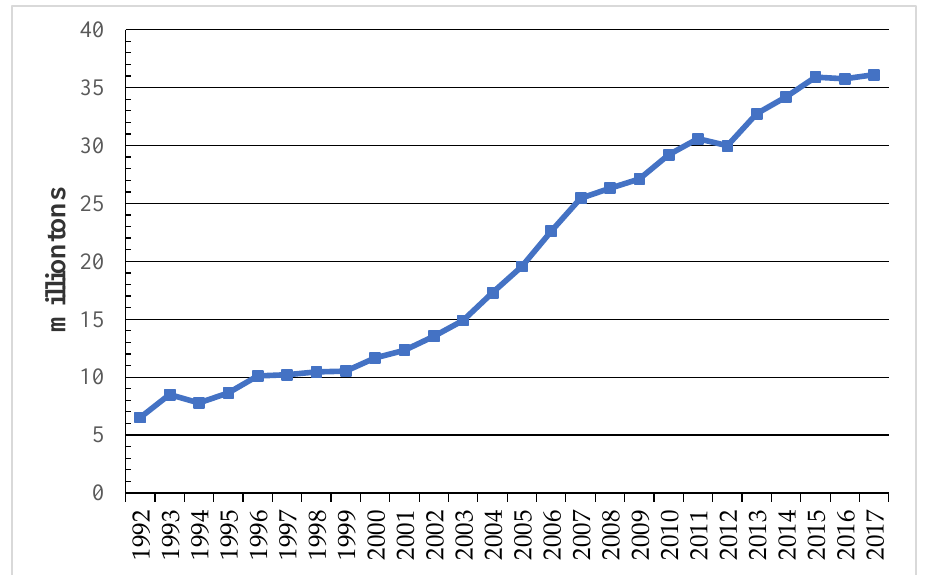
Figure 3. The power CO 2 emissions of China from 1992 to 2017.